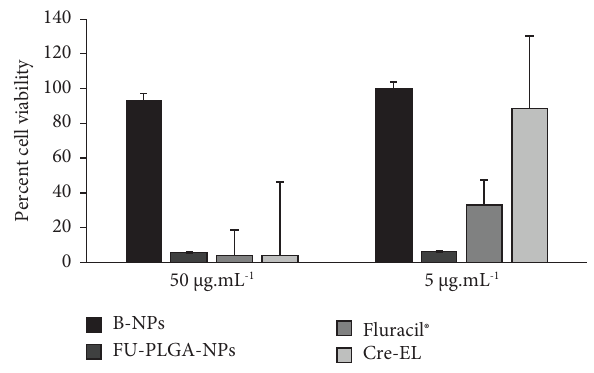
Figure 7: Viability of NCI-H69 cells following administration of Fluracil ® , Cre-EL, B-NPs, and FU-PLGA-NPs. Te diferent for- mulations were applied to the cells for 120hours after they had been seeded into 96-well plates. Cell viability was assessed using the MTT test, and the outcomes were reported as a % of control wells (cells without